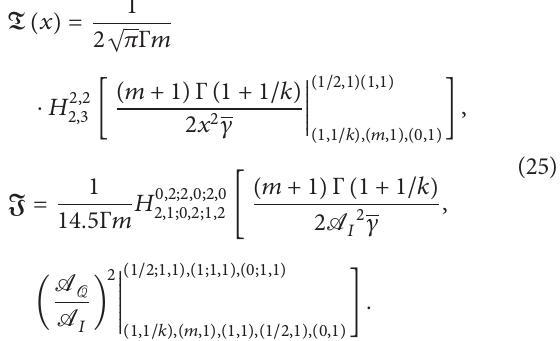
Figure 1: ASEP of 2 × 2 MIMO system using MMSE-OSIC over WG fading channel subject to Laplacian and Gaussian